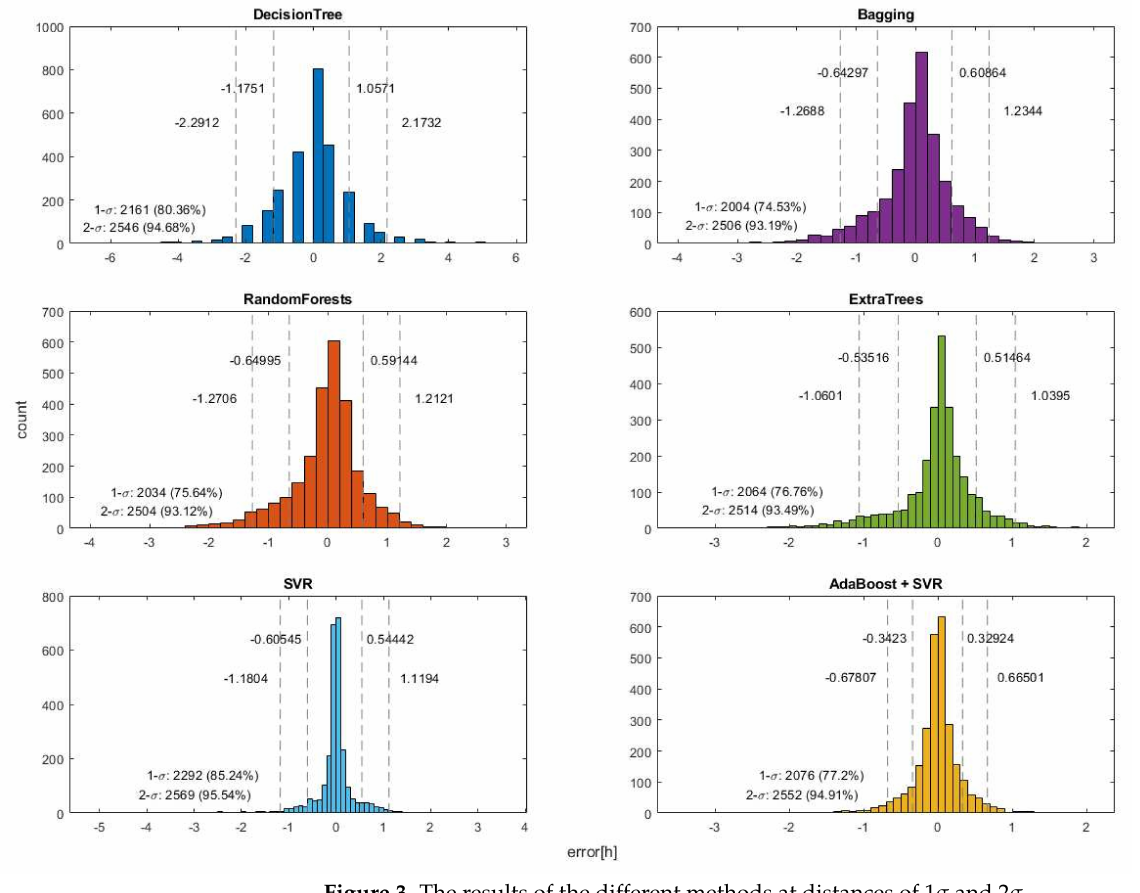
Figure 3. The results of the different methods at distances of 1 σ and 2 σ . Table 4. The results of the different methods at distances of 1 σ and 2 σ